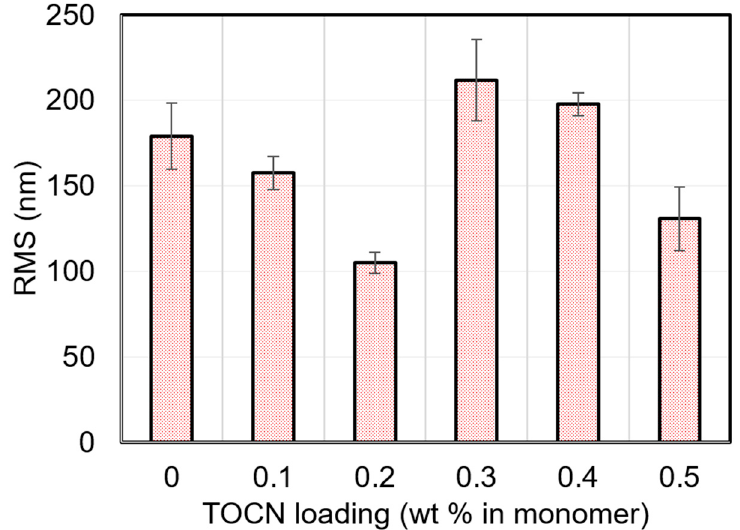
Figure A3. RMS roughness data obtained from AFM scans of TFN membranes with various TOCN loading amounts.